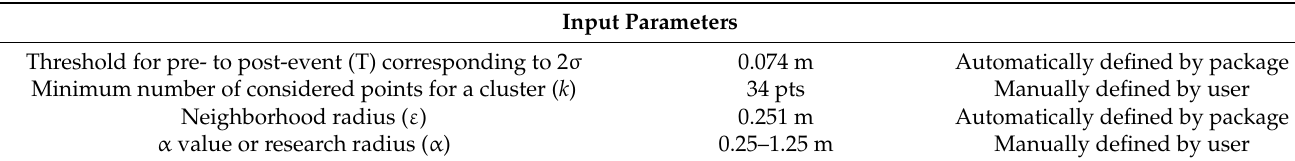
Table 1. Example of input parameters used for the La Cornalle cliff case study.